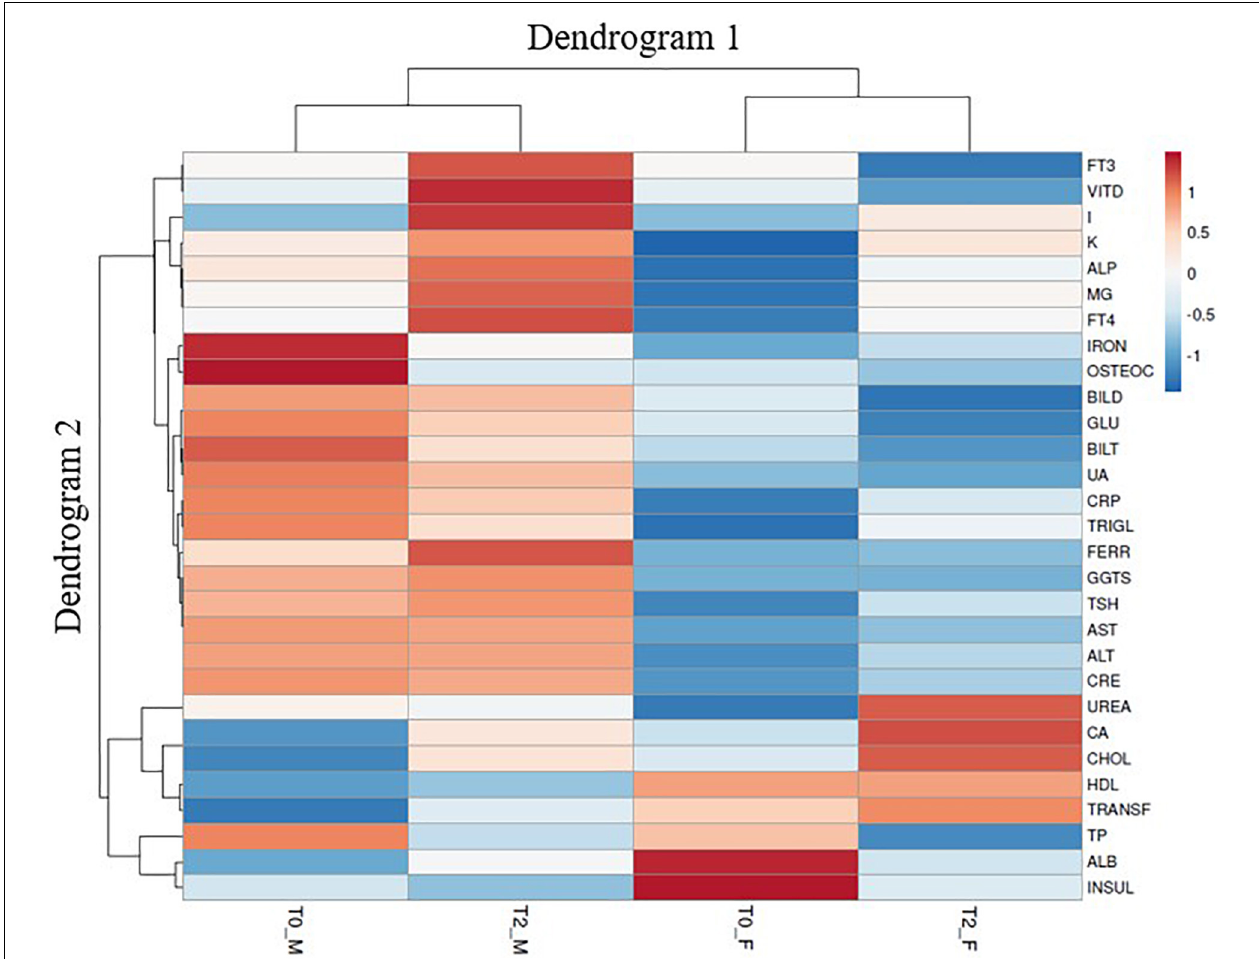
FIGURE 1 | Flowchart of the interventional nutritional study during the period of 12 days of administration of biofortified iodine curly endive and curly endive without any biofortification. Created with “BioRender.com”.